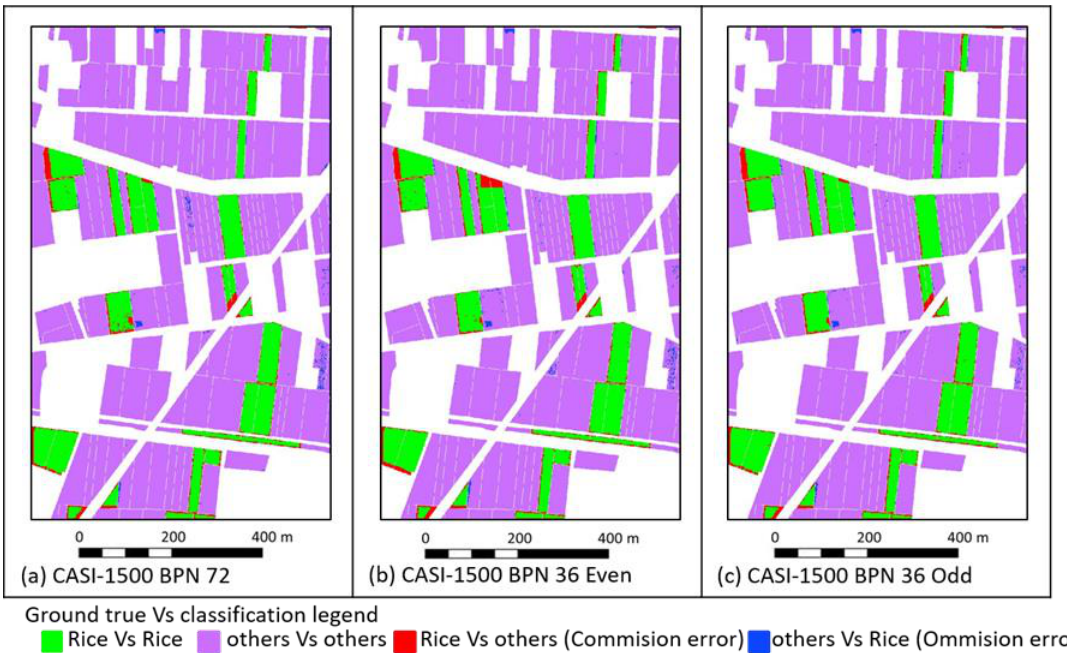
Figure 7. Thematic map of the full-size image classification of BPN on CASI-1500 (hyperspectral) with the different bands. Note: the red parts are rice, classified as other categories (commision error). The blue parts are others, classified as rice (ommision error). ( a ) CASI-1500 BPN 72; ( b ) BPN 36 Even; and ( c ) BPN 36 Odd.